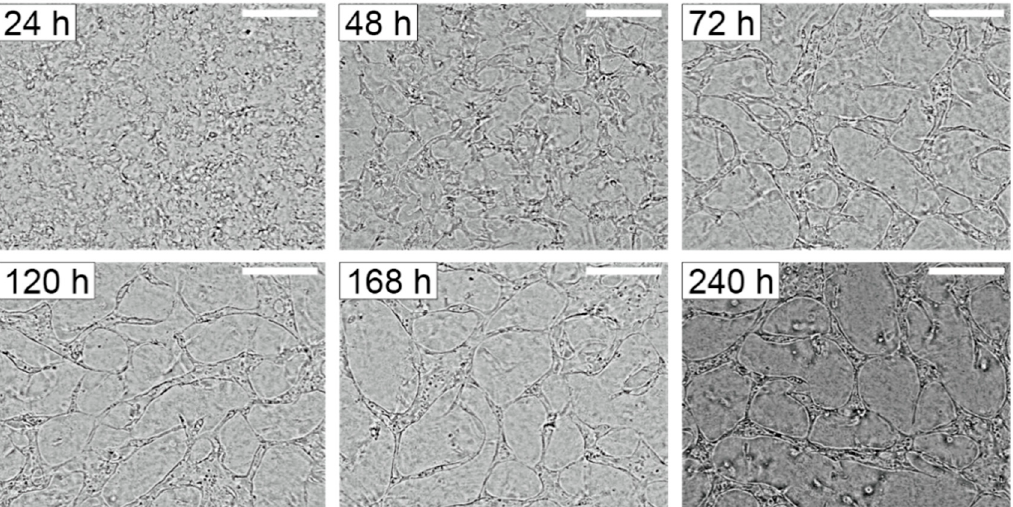
Figure 4. Development of vascular networks of human umbilical vein endothelial cells (HUVECs) formed within the device under normoxia for 240 h. Scale bar = 150 µ